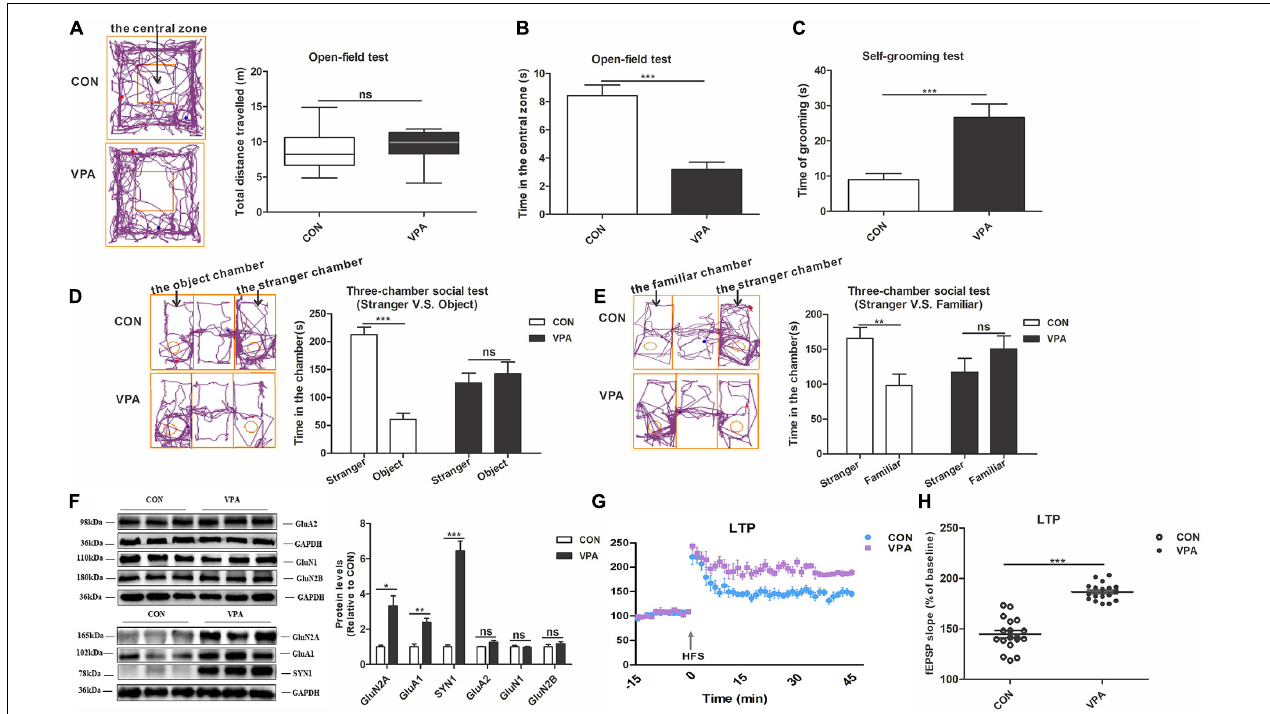
FIGURE 2 | Autism-like behavioral deficits and dysregulation of homeostatic synaptic plasticity in the PFC of VPA-exposed offspring. (A) The tracing and total distance traveled in the open-field test ( n = 20–22 per group, Z 1 = –1.785, P = 0.074). (B) The time spent in the central zone in the open-field test ( n = 20–22 per group, t 33 = 5.716, P < 0.001). (C) The time spent self-grooming in the open-field test ( n = 20–22 per group, t 27 = –4.131, P < 0.001). (D) The tracing and social interaction in the three-chamber test (stimulus: a stranger rat vs. an object) ( n = 20–22 per group, t 38 = 8.692, P < 0.001 for CON group; t 38 = –0.61, P = 0.546 for VPA group). (E) The tracing and recognition of social novelty in the three-chamber test (stimulus: a stranger rat vs. a familiar rat) ( n = 20–22 per group, t 38 = 2.98, P = 0.005 for CON group; t 38 = –1.227, P = 0.227 for VPA group). (F) Western blot and quantification analyses of GluN2A, GluA1, SYN1, GluA2, GluN1, and GluN2B protein in the PFC of offspring from the CON and VPA groups ( n = 3 per group). (G) Summary graphs of PFC LTP in CON and VPA ( n = 9 slices from 4 rats per group). (H) LTP magnitude was measured as an average potentiation at 41–45 min after the onset of HFS induction ( n = 9 slices from 4 rats per group). Each experiment was repeated at least three times. The values are the median (P25–P75) (A) or means ± SEMs (B–H) . Mann–Whitney U test (A) , Student’s t -test (B–H) , * P < 0.05, ** P < 0.01, *** P < 0.001, ns, not significant; VPA, valproic acid; PFC: prefrontal cortex; PND, Postnatal Day; LTP, long-term potentiation; fEPSP, field excitatory postsynaptic potentials; HFS, high frequency stimulation.